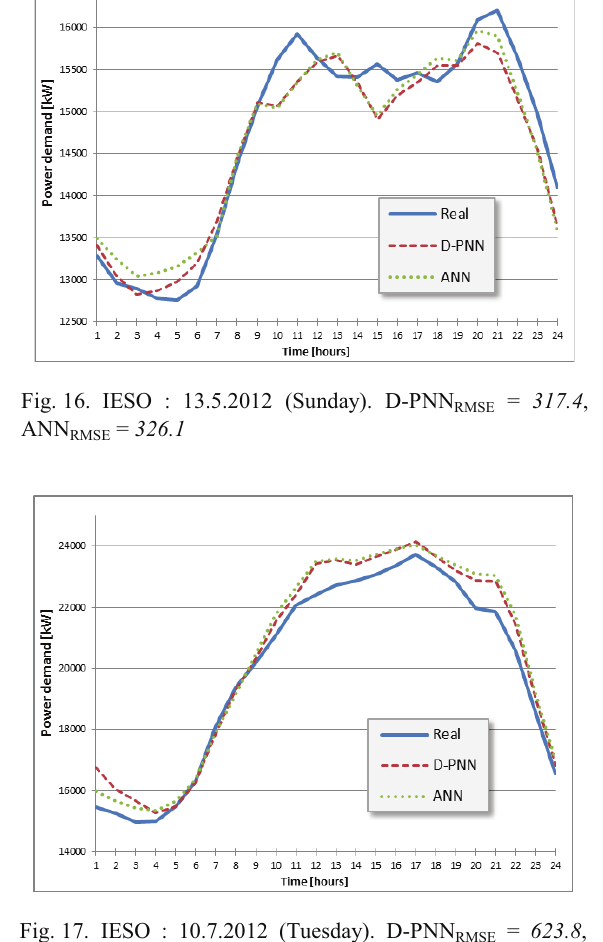
Fig. 17. IESO : 10.7.2012 (Tuesday). D-PNN RMSE = 623.8 , ANN RMSE = 651.2